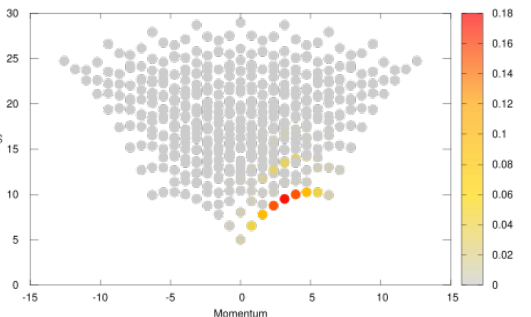
| 2 = | (cid:104){ I } | N , X ; P = π (cid:105) | 2 for n = 1, c = 0.1, and N = 8. Each circle N j j } k j and the energy ∑ N j = 1 yr